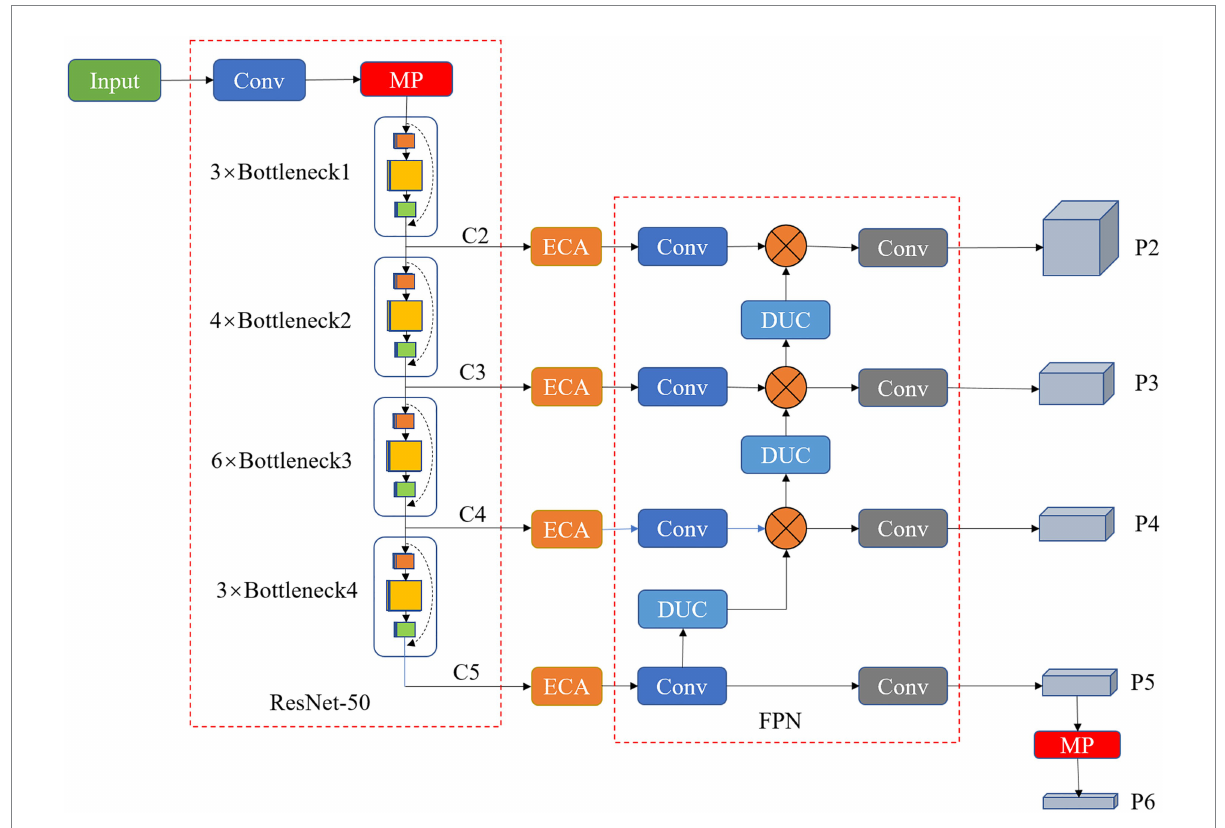
FIGURE 5 Structure of the improved ResNet50-FPN-ED backbone network.